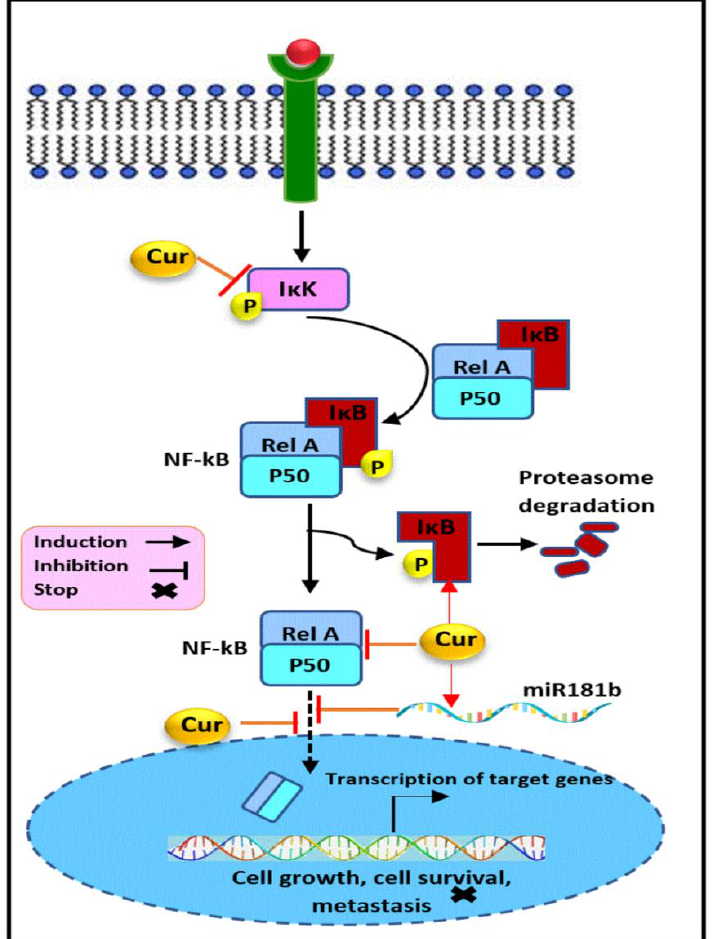
Figure 4. The modulatory effect of curcumin on the NF- κB pathway. Curcumin inhibits the NF- κB signaling pathway through the regulation of its key components. Curcumin upregulates IκB and miR181b expression and downregulates NF- κB and IKK , and suppresses the NF- κB translocation into the nucleus, which results in the inhibition of cellular proliferation, survival, metastasis, and angiogenesis in hormone receptor negative breast cancer. Cur: curcumin, IκK : inhibitor of kappa B kinase, IκB: inhibitor of NF - κB, Rel A: P65.